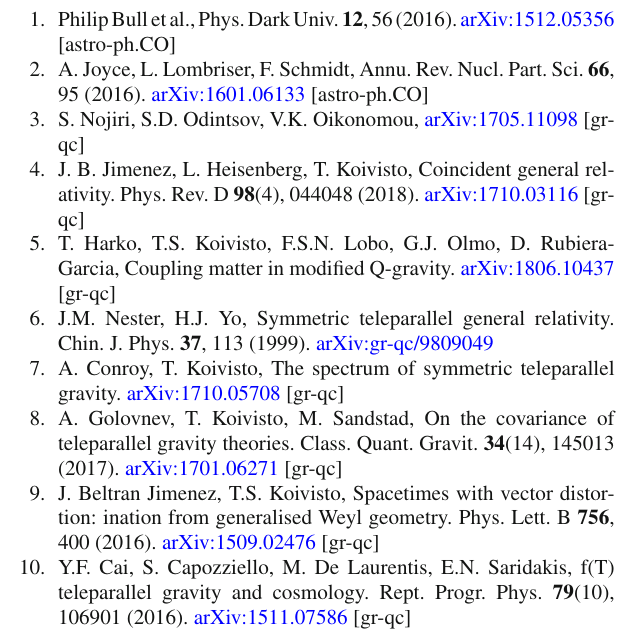
points are attracted into it irrespective of the initial condi- tions), it is shown that the cosmological constant problems, such as the fine tuning problem, could be solved in this